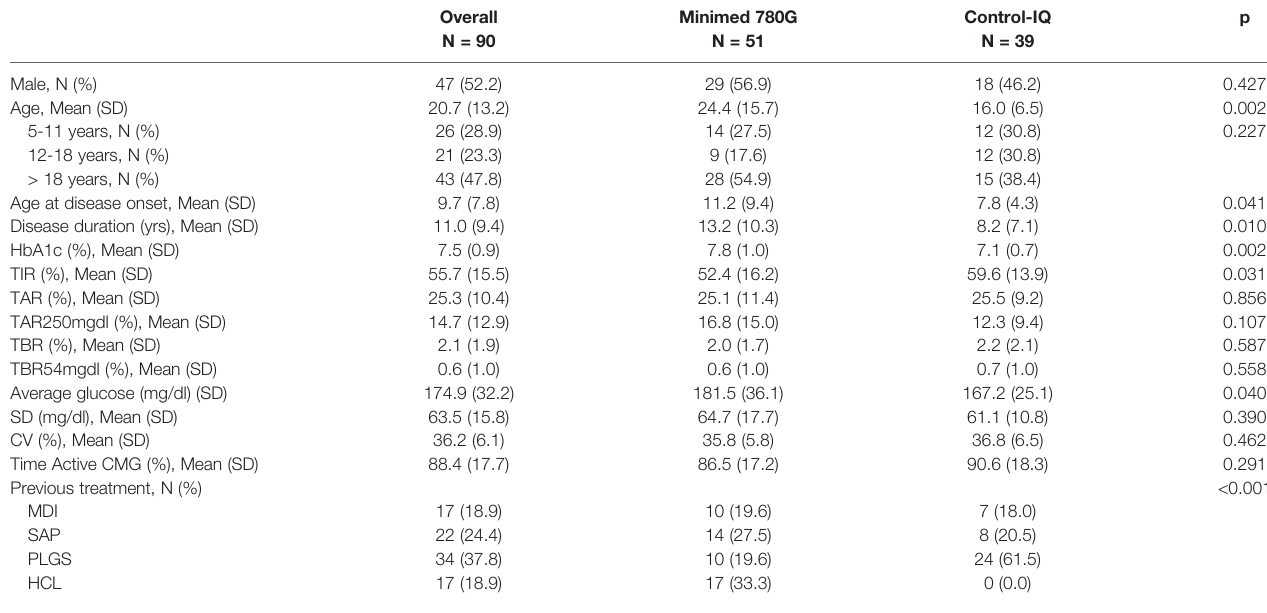
TABLE 1 | Patient characteristics at baseline (T0), overall and by treatment